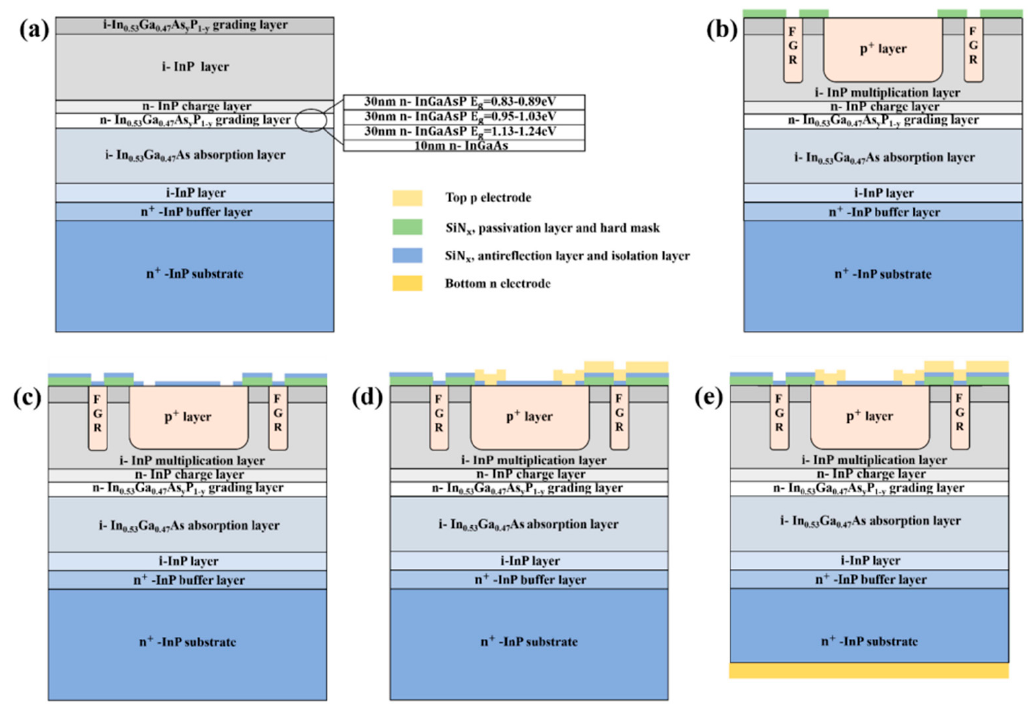
Figure 42. ( a ) Cross-sectional diagram, and ( b ) process flow for the planar geometry SAGCM InGaAs/InP APD with FGR structure, the optimum values for L1 and L2 are 12 µ m and 8 µ m, respectively( c – e ). Reproduced from [95], IEEE, open access, 2022.